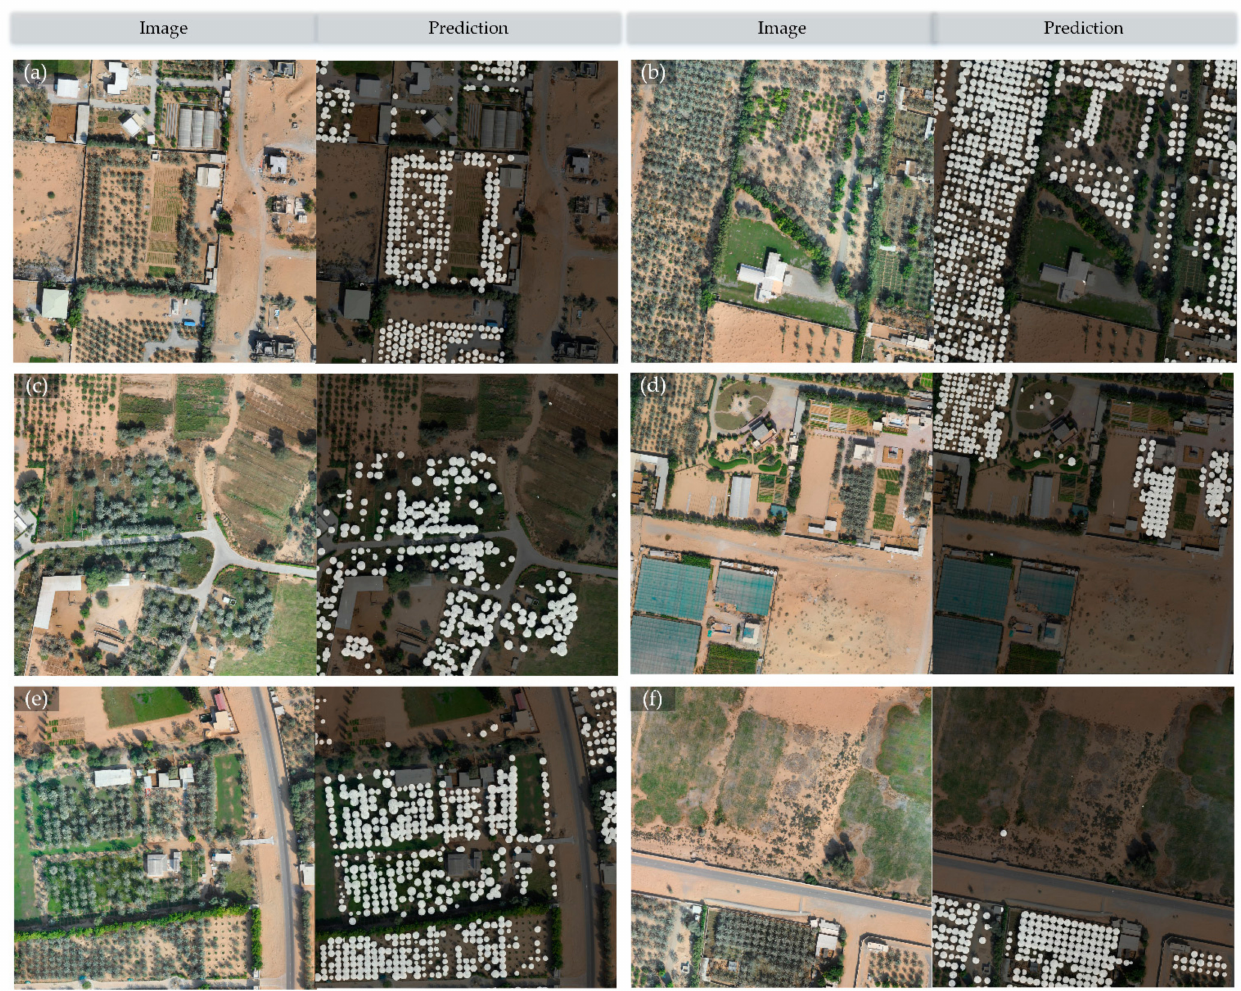
Figure 12. ( a – f ) Segmentation output of the proposed model for different randomly selected image tiles with larger